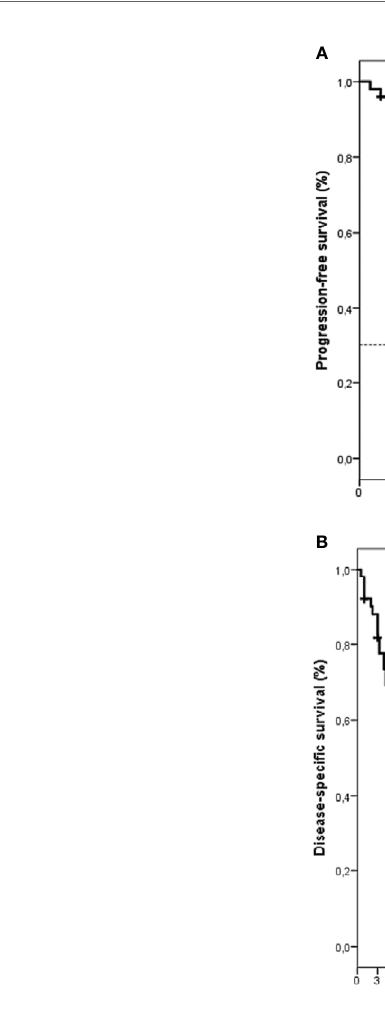
FIGURE 1 | Kaplan-Meier curves of progression-free survival (PFS) (A) and disease-speci fi c survival (DSS) (B) for the whole